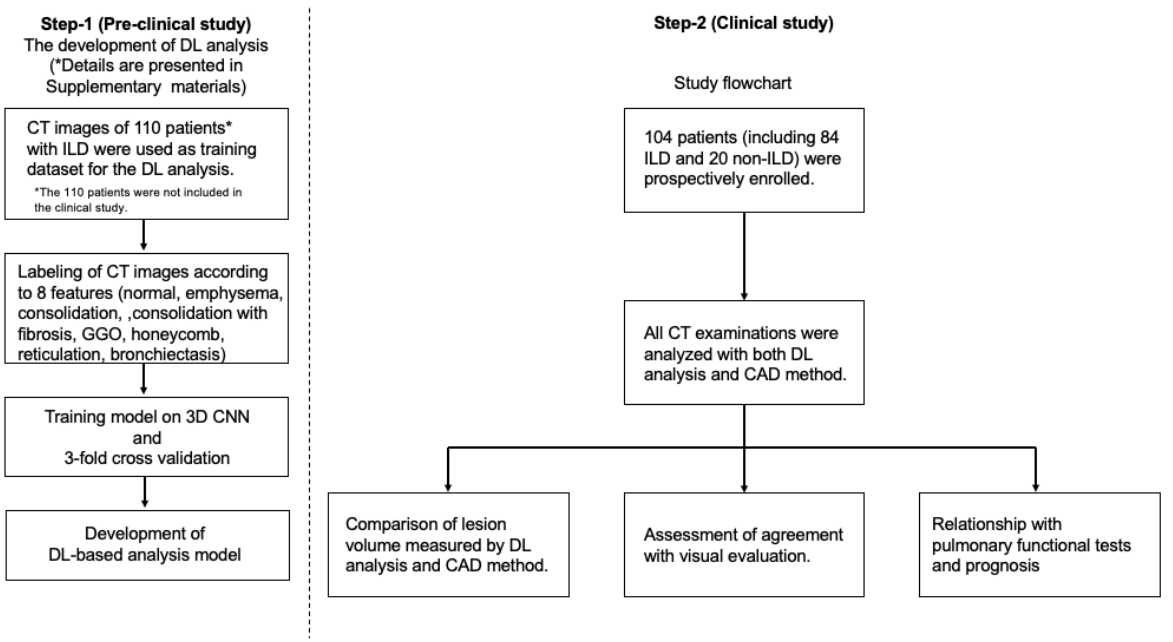
Figure 1. Flowchart of the study design. Step-1 (the development of deep-learning (DL)-based analysis) details described in the Supplementary Materials